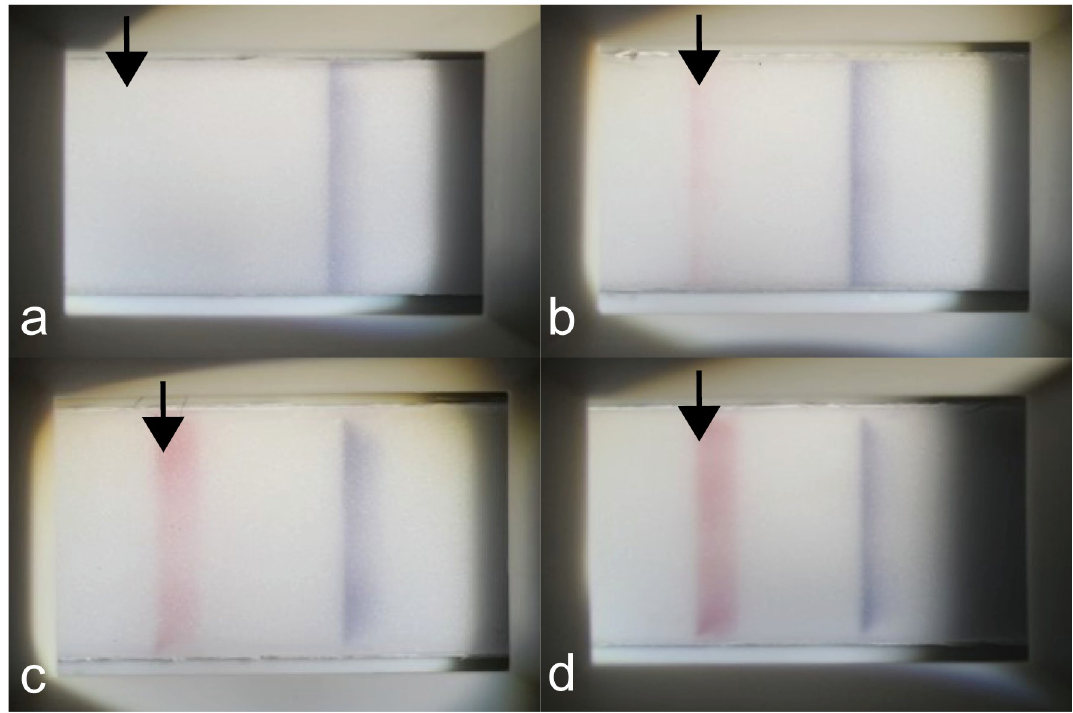
Fig 1. Semiquantitative analysis of matrix metalloproteinase 9 immunoassay according to the colour intensity of reagent band (arrow). (a) Negative. (b) Weak positive. (c) Moderate positive. (d) Strong